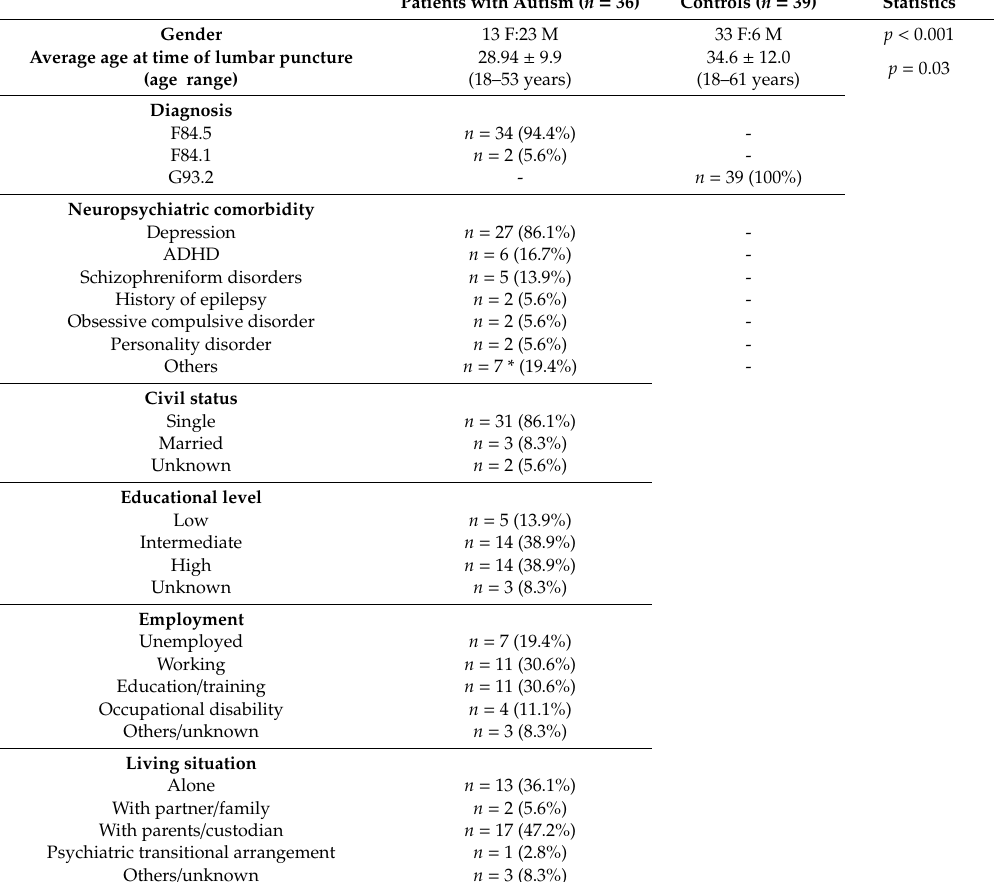
Table 1. Clinical and demographic data of patients and